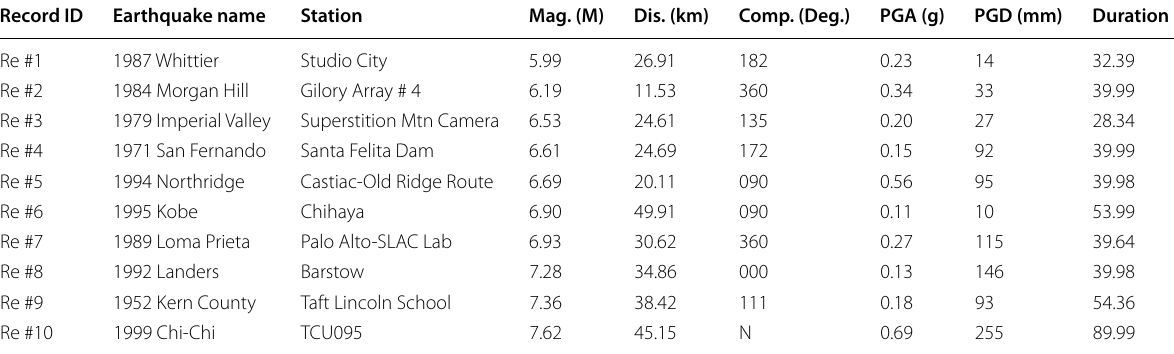
Table 1 Characteristics of the